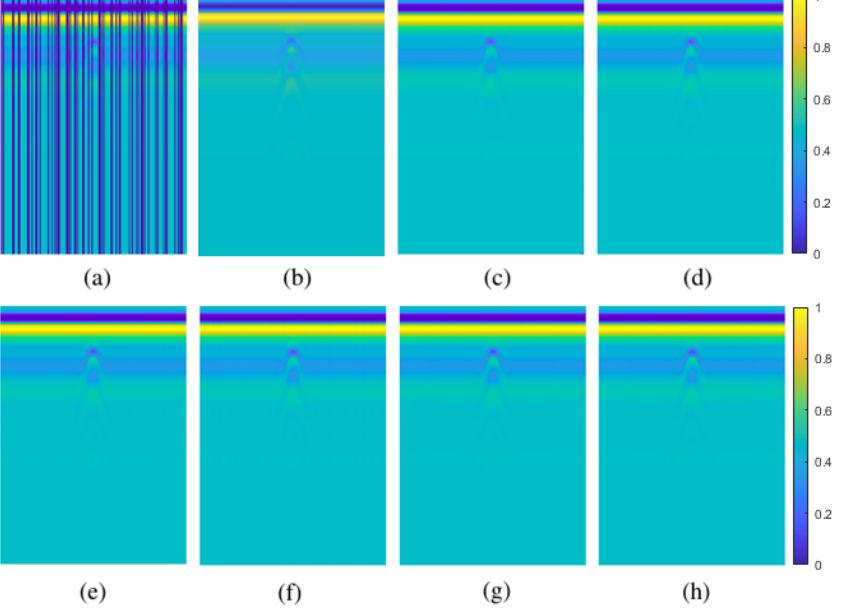
Figure 11. 30% column-wise missing data case for simulated data: ( a ) GPR image with missing entries, ( b ) original GPR image, recovered images by ( c ) GoDec, ( d ) NMC, ( e ) Lmafit, ( f ) NNM, ( g ) PEN-Net, ( h ) DIP.